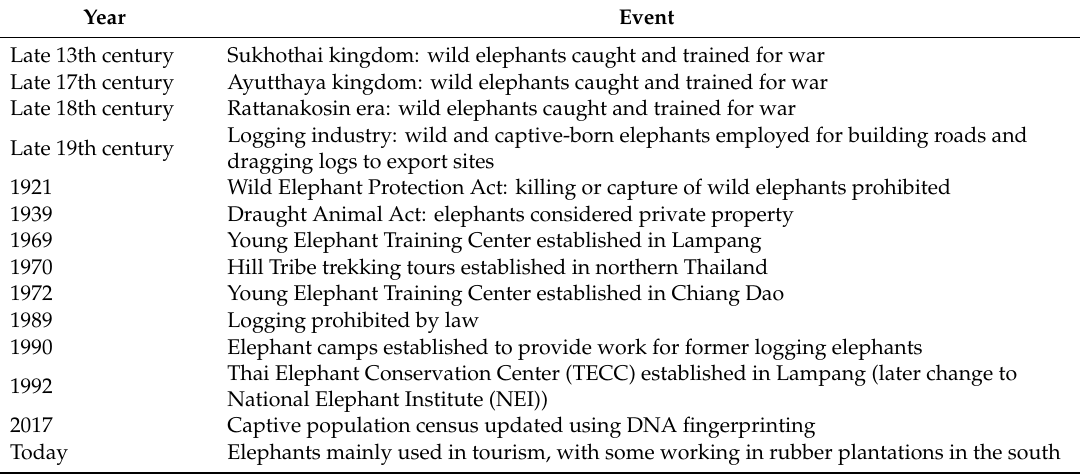
Table 1. Summary of significant events in the management and use of captive elephants in